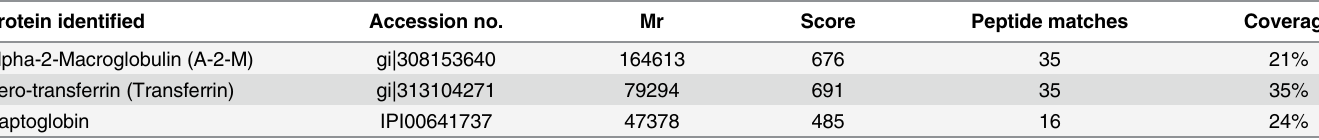
The peptide mass list from MS analysis was used to search the NCBI database using the MASCOT search engine (Matrix Science). The taxonomy used was human or bacteria. Table lists the proteins identi fi ed by MS analysis together with details of individual mass value